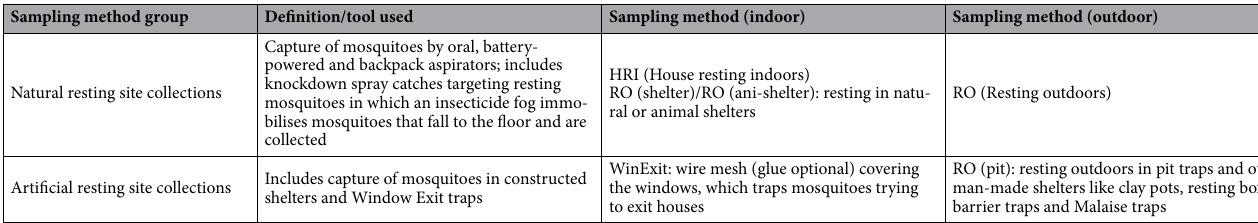
Table 2. Sampling methods for resting and other behaviours. The different sampling methods recorded in Massey et al. (2016) 19 targeting resting mosquitoes were grouped into categories of techniques/tools used as proposed by Farlow et al. (2020) 9 . Artificial resting sites are specifically constructed to lure and catch resting mosquitoes, while Natural resting sites are not, i.e. a house is not specifically constructed to lure and catch resting mosquitoes so it is considered a Natural resting